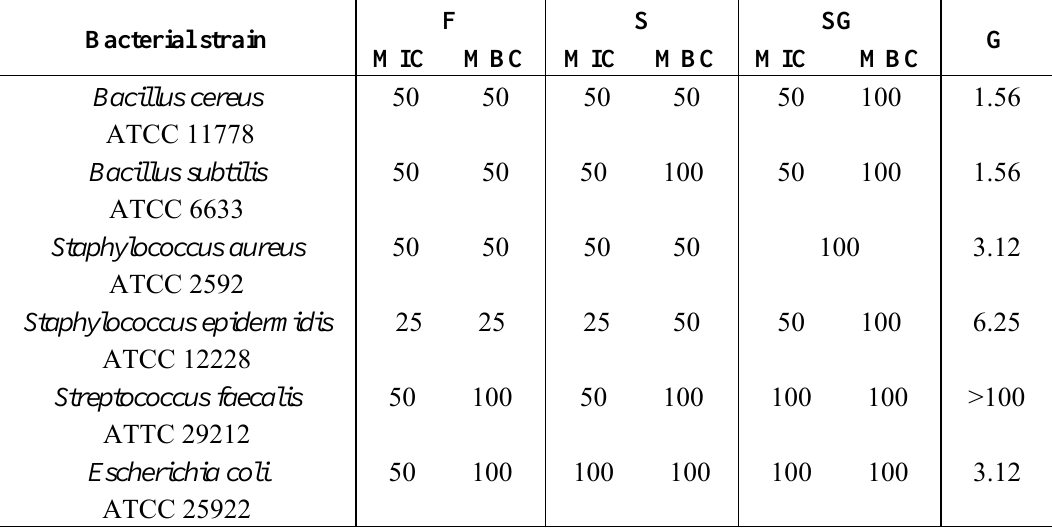
Table 2. MIC and MBC values (  g/mL) of essential oils from Origanum vulgare L. ssp. hirtum (Link) Ietswaart growing wild in Campania and MIC of reference antibiotic. Results are the mean of three